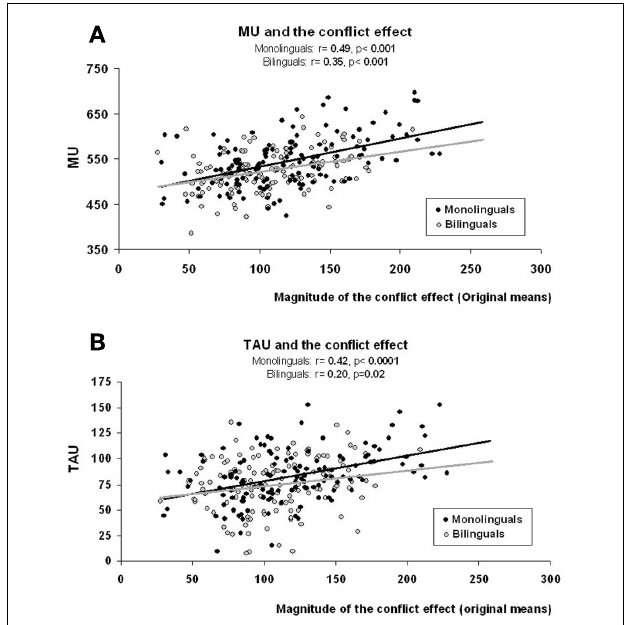
FIGURE 2 | Percentile distribution of the magnitude of the conflict effect captured by μ (A) and τ (B), broken by group (monolinguals and bilinguals). The percentiles are based on the participants’ scores. Error bars represent the SE.